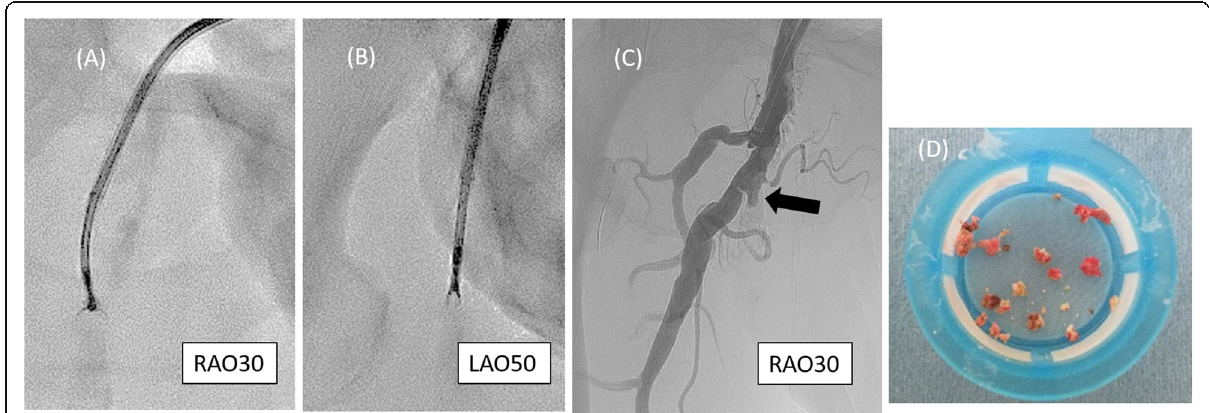
Fig. 2 Removal of calcified plaque using the biopsy forceps. ( A ) The direction of the guiding sheath was adjusted by manually compressing the puncture site. ( B ) Contact between the open jaw of the forceps and the calcified plaque was checked using two perpendicular views before grasping. ( C ) The hollow at the ostium of the SFA (arrow) was created after repeating this procedure 21 times. ( D ) Removed calcified plaque.